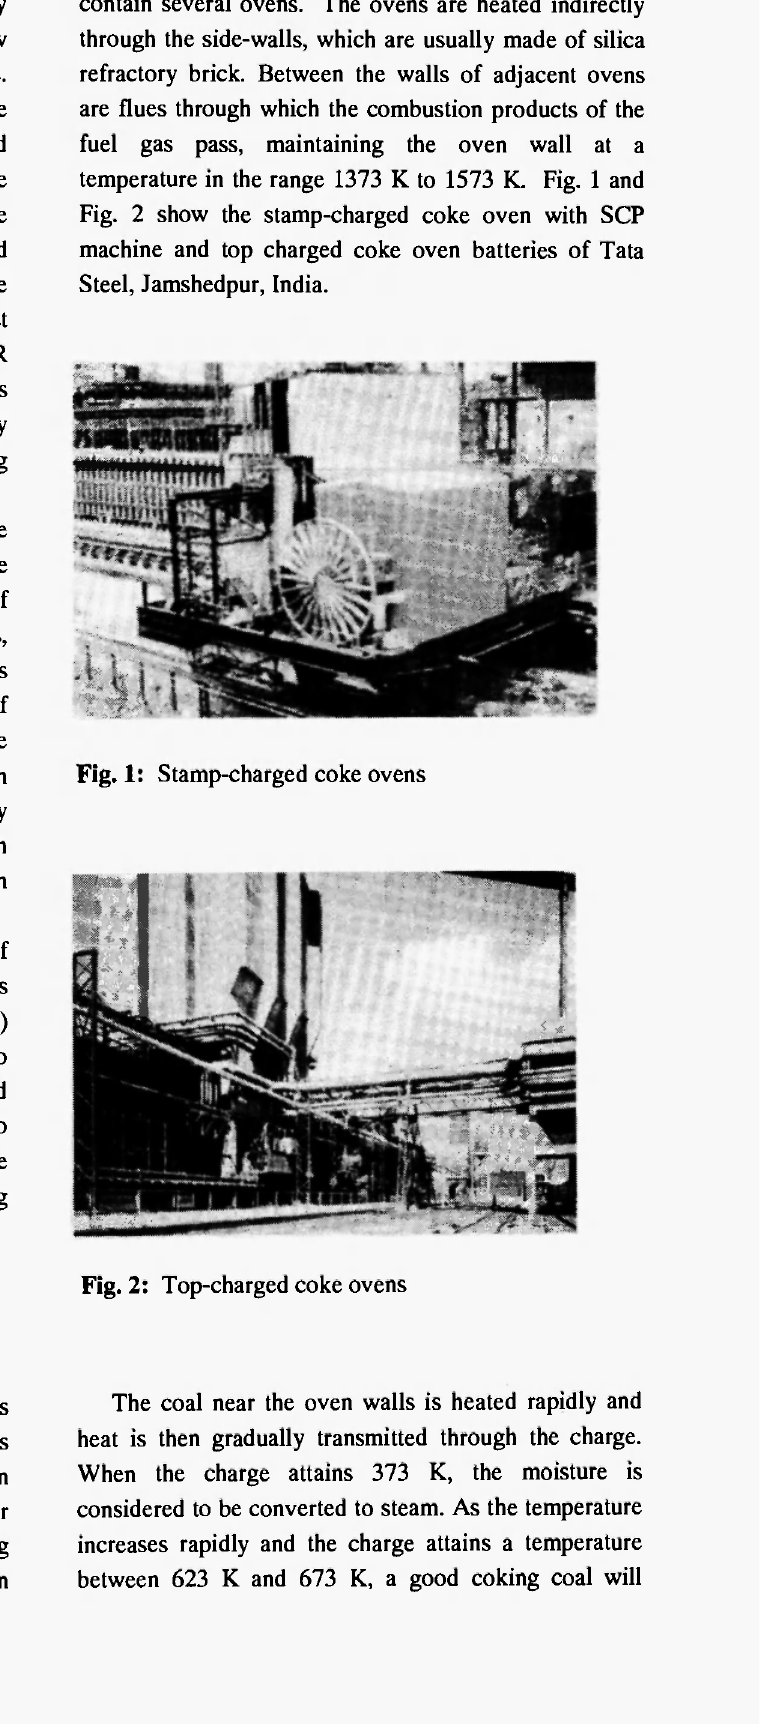
Fig. 2: Top-charged coke